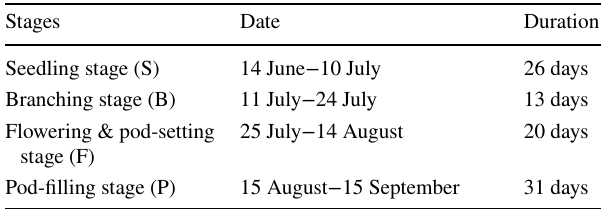
Table 3 Division of soybean growth stages in the Huaibei Plain study area in Anhui Province,